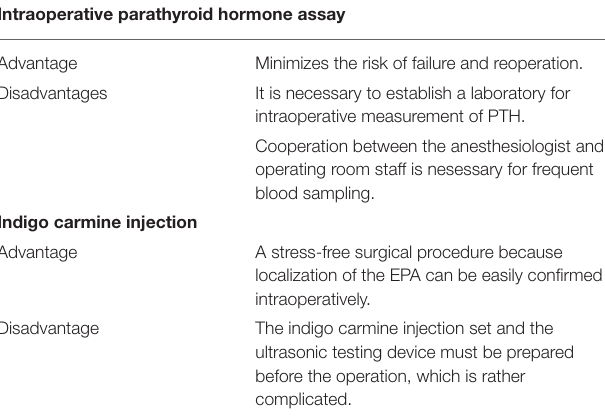
TABLE 3 | Advantages and disadvantages of intraoperative parathyroid. Hormone assay and indigo carmine injection for EPA and conventional surgery. Intraoperative parathyroid hormone